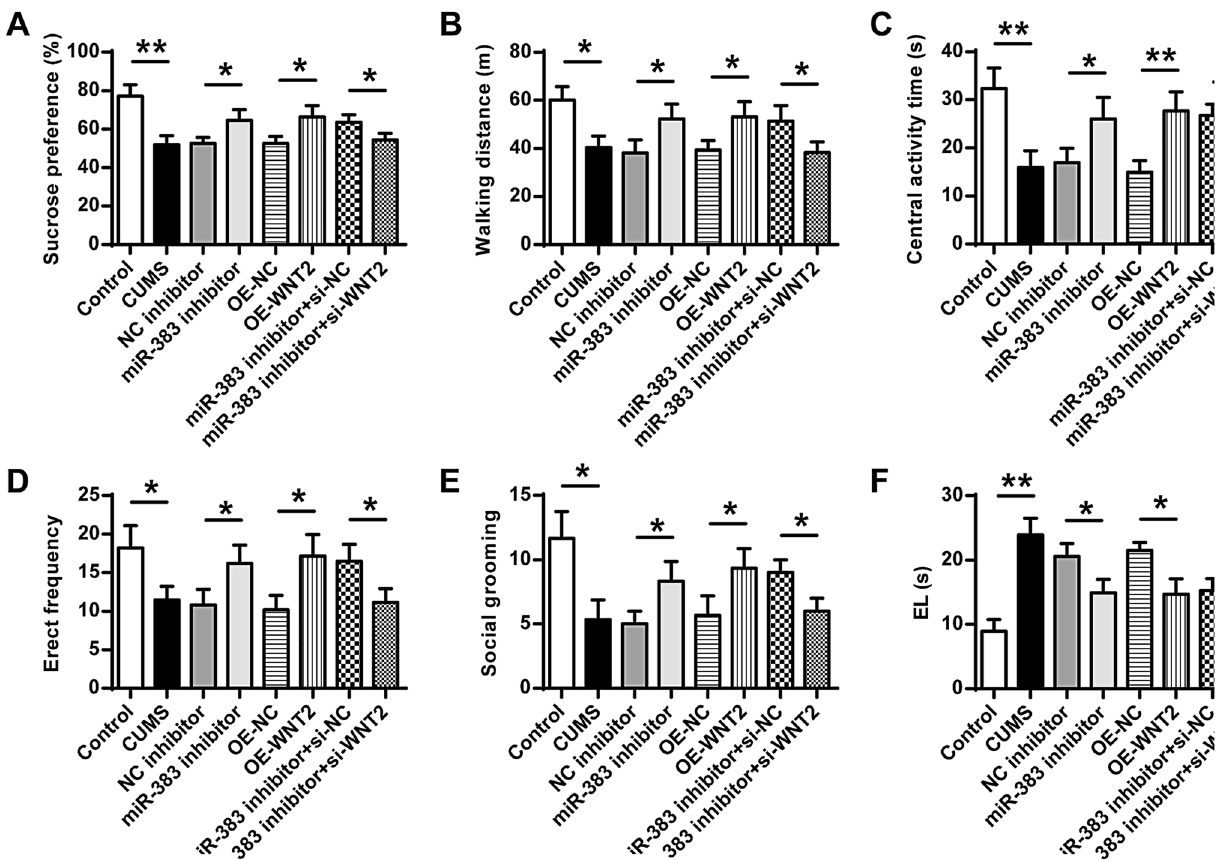
Figure 3. Downregulation of miR-383 or upregulation of Wnt2 could reduce CUMS-induced depression-like behaviors in rats. The sucrose preference ( A ), walking distance ( B ), central activity time ( C ), Erect frequency ( D ), Social grooming ( E ) and Escape latency (EL) ( F ) of rats in different groups. N = 6. Data were presented as mean ± SD and each experiment was repeated three times. * P < 0.05, ** P < inhibitor group compared with that in NC inhibitor group (Fig. 2E, ANOVA, F (3,8) = 74.391, P = 0.000; LSD test, t = − 7.592, P = 0.002; Fig. 2F, ANOVA, F (3,8) = 50.501, P = 0.000; LSD test, t = − 6.101, P = 0.004). Furthermore, the rats were injected with miR-383 inhibitor, NC inhibitor, OE-NC (the negative control of Wnt2 overexpres- sion), OE-Wnt2 (Wnt2 overexpression), miR-383 inhibitor plus si-NC (the negative control of Wnt2 silencing) or miR-383 inhibitor plus si-Wnt2 (Wnt2 silencing), and then submitted to CUMS. Then the expression levels of miR-383 were evaluated after rats were recovered for 1 week and the results indicated that miR-383 inhibi- tor could significantly decrease the expression levels of miR-383 in comparison to that in NC inhibitor group (ANOVA, F (7,40) = 25.858, P = 0.000; LSD test, t = 6.163, P = 0.004), while no obvious change was observed in other groups (Fig. 2G). In addition, the expression levels of Wnt2 in these groups were also measured and the results showed that miR-383 inhibitor significantly increased the expression levels of Wnt2 compare with that in NC inhibitor group (Fig. 2H, ANOVA, F (7,40) = 33.815, P = 0.000; LSD test, t = − 6.187, P = 0.003; Fig. 2I, ANOVA, F (7,40) = 49.170, P = 0.000; LSD test, t = − 8.561, P = 0.001), OE-Wnt2 increased the expression levels of Wnt2 compared with that in OE-NC group (Fig. 2H, ANOVA, F (7,40) = 33.815, P = 0.000; LSD test, t = − 9.554, P = 0.001; Fig. 2I, ANOVA, F (7,40) = 49.170, P = 0.000; LSD test, t = − 9.684, P = 0.001), and miR-383 inhibitor plus si-Wnt2 significantly reversed miR-383 inhibitor enhanced expression of Wnt2 at both mRNA and protein lev- els (Fig. 2H, ANOVA, F (7,40) = 33.815, P = 0.000; LSD test, t = 6.146, P = 0.004; Fig. 2I, ANOVA, F (7,40) = 49.170, P = 0.000; LSD test, t = 7.976, P = 0.001). These results indicated that Wnt2 was a target of miR-383. Downregulation of miR‑383 or upregulation of Wnt2 could reduce CUMS‑induced depres‑ sion‑like behaviors. The specific roles of miR-383 and Wnt2 in the development of depression-like behav- iors of CUMS-induced rats were then explored. The sucrose preference test results showed that the sucrose consumption rate was decreased in CUMS-induced rats compared with that in the control group (ANOVA, F (7,40) = 11.073, P = 0.000; LSD test, t = 5.759, P = 0.005), increased in the miR-383 inhibitor group compared with that in NC inhibitor group (ANOVA, F (7,40) = 11.073, P = 0.000; LSD test, t = − 3.284, P = 0.030), increased in the OE-Wnt2 group compared with that in OE-NC group (ANOVA, F (7,40) = 11.073, P = 0.000; LSD test, t = − 3.350, P = 0.029), and also decreased in miR-383 inhibitor plus si-Wnt2 group compared with that in miR-383 inhibitor plus si-NC group (ANOVA, F (7,40) = 11.073, P = 0.000; LSD test, t = 2.933, P = 0.043) (Fig. 3A). Based on the tests